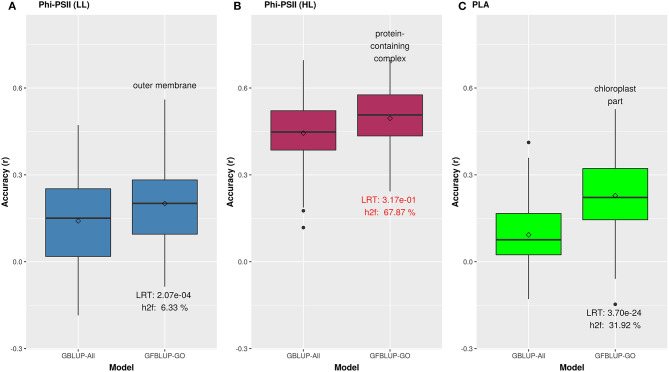
Biological priors based on top GO cellular components improving genomic prediction accuracy for growth related traits. Prediction accuracy of the best GFBLUP models using Gene Ontology (GO) cellular components gene groups, compared to the GBLUP benchmark (without prior biological knowledge). The accuracy of benchmark model may differ within corresponding figures of Figures 2, 3, because it is calculated from the corresponding time point, where improvement by GFBLUP was observed. Accuracy was calculated as Pearson correlation between true vs. predicted values. The GBLUP-ALL model uses all markers in GBLUP; GFBLUP-GO models use the top GO cellular component terms mentioned in the text above. The text in the bottom of boxplots shows the likelihood ratio test p-value (LRT) and proportion of genomic heritability explained (hf2) by corresponding GO model. (A) Accuracy for ΦPSII under low light irradiance levels (LL). (B) Accuracy for ΦPSII under high light irradiance (HL). Similar to Figure 2, the GFBLUP-GO model did not pass all of our model evaluation criteria (see Model Performance Evaluation), though showing some improvement. (C) Accuracy for PLA.